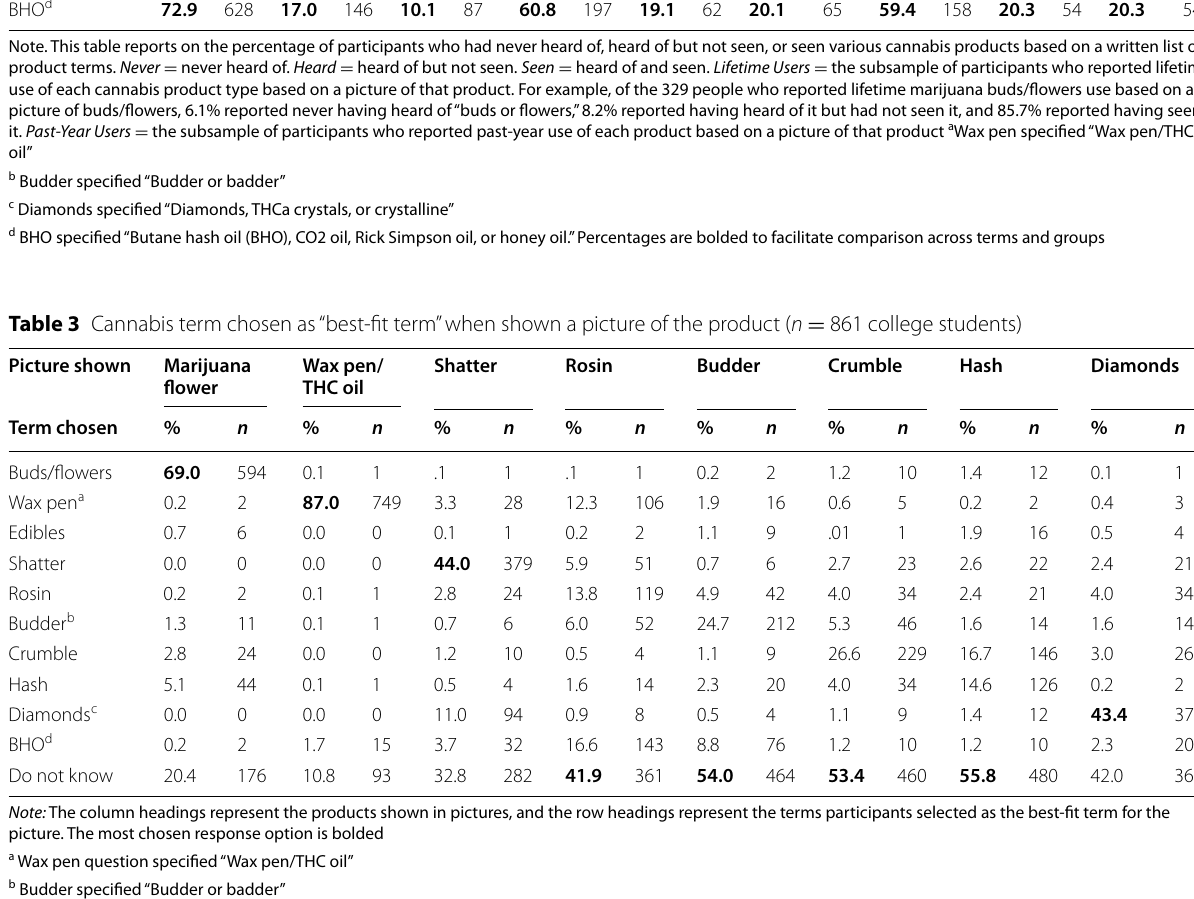
861 college students) and in subsamples of lifetime and past-year users =